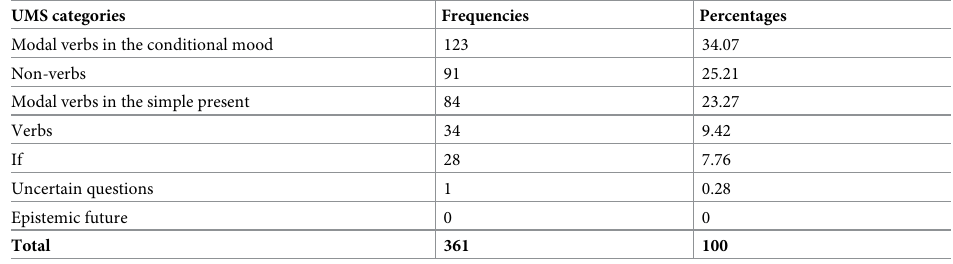
Table 5. Frequencies and percentages of UMs in BMJ 2013.